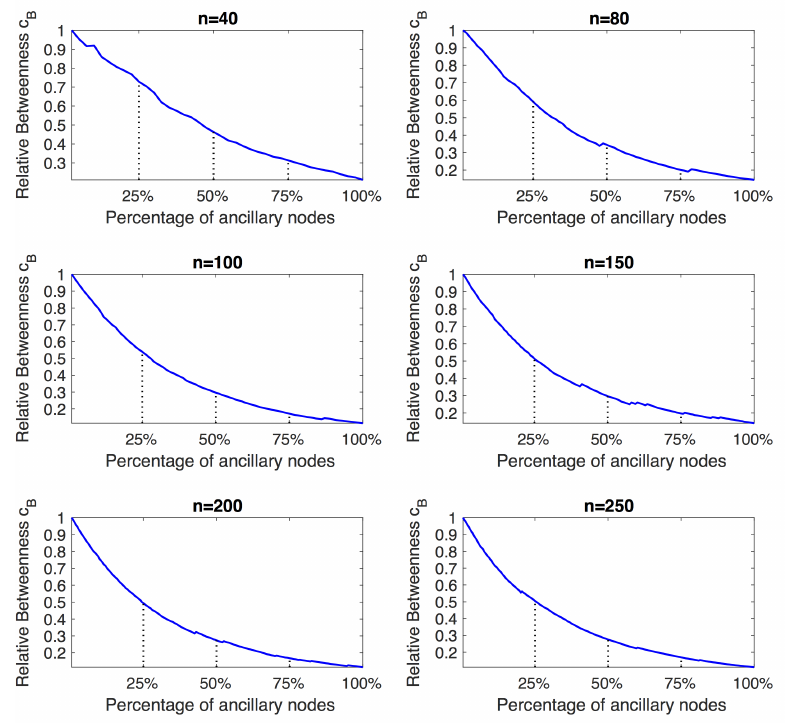
Fig. 7. Relative Betweenness network